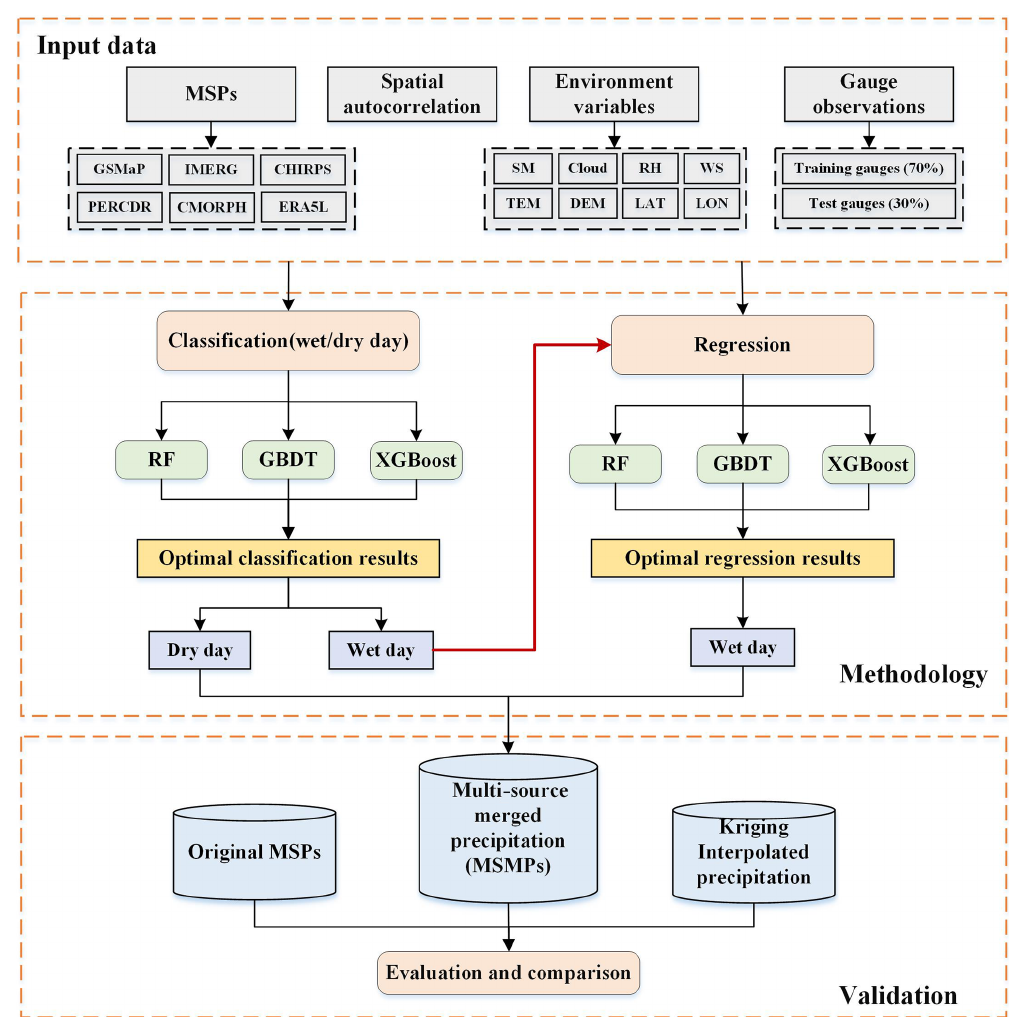
Figure 2. Flowchart of the merging strategy used in this study (LAT is latitude, LON is longitude, RH is relative humidity, SM is soil moisture, TEM is temperature, and WS is wind